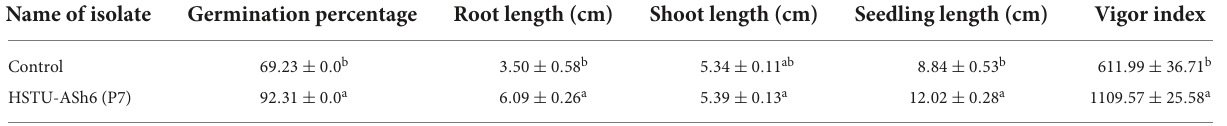
TABLE 1 Germination percentage, root length, shoot length, seedling length, and vigor index of tomato plant with the strain at 9 days of seed plantation. Name of isolate